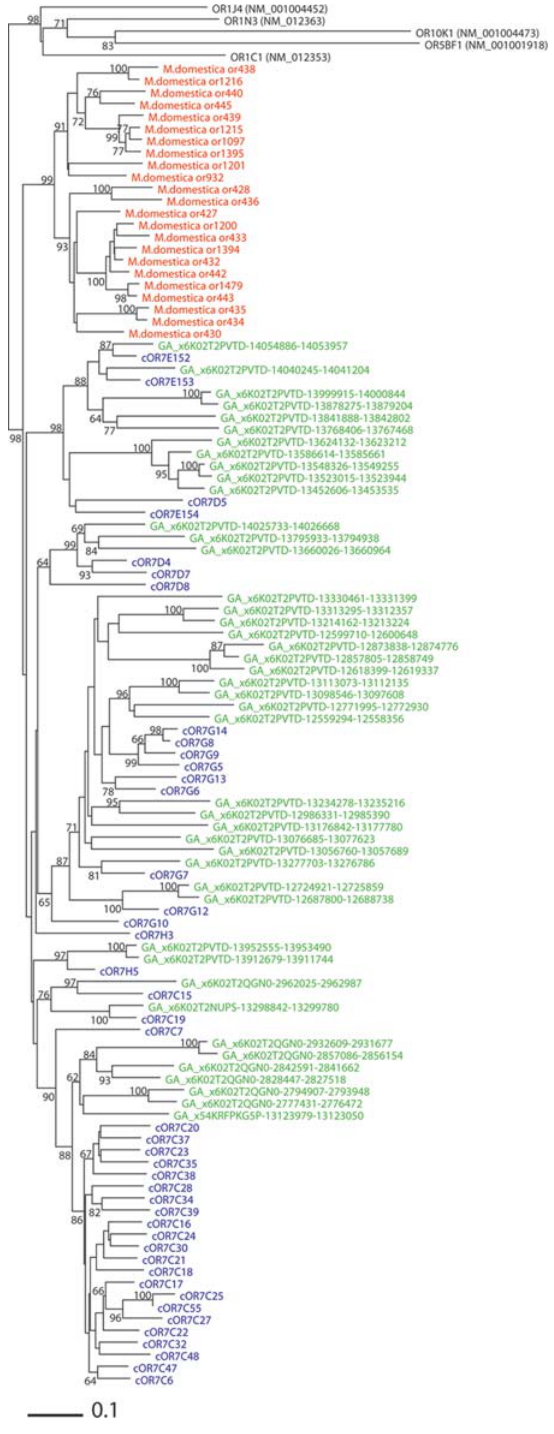
Figure 3. A phylogenetic tree of an OR gene subgroup called family 7. The tree was constructed by the neighbor-joining method [29], based on the Poisson correction distance [30] matrices. OTUs written using red fonts indicate opossum ORs, blue fonts indicate dog ORs and green fonts indicate mouse ORs. Five human ORs belonging to other subgroups were used as outgroups. Bootstrap values were obtained by 1000 resamplings, and the values . 60% are shown.